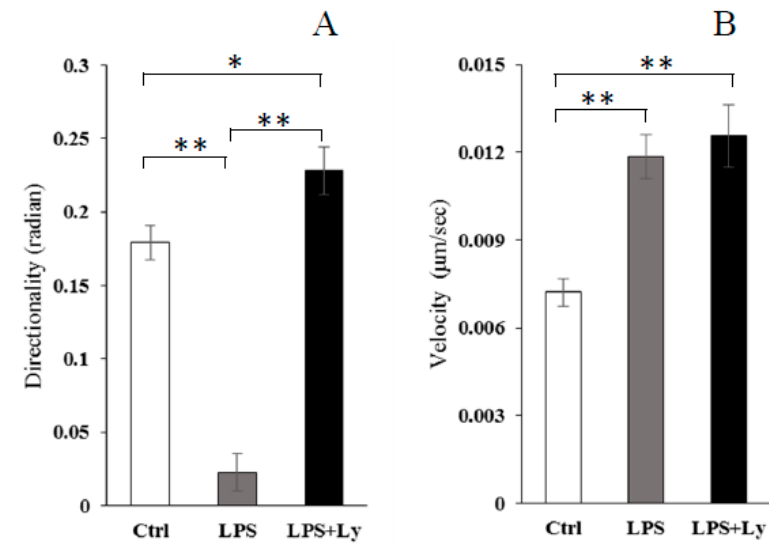
Figure 3. Direct comparison of 5 frames from the video (selected frames in order from 0 h to 10 h) with equivalent frames from the chemotaxis of macrophages toward damaged C2C12 cells.